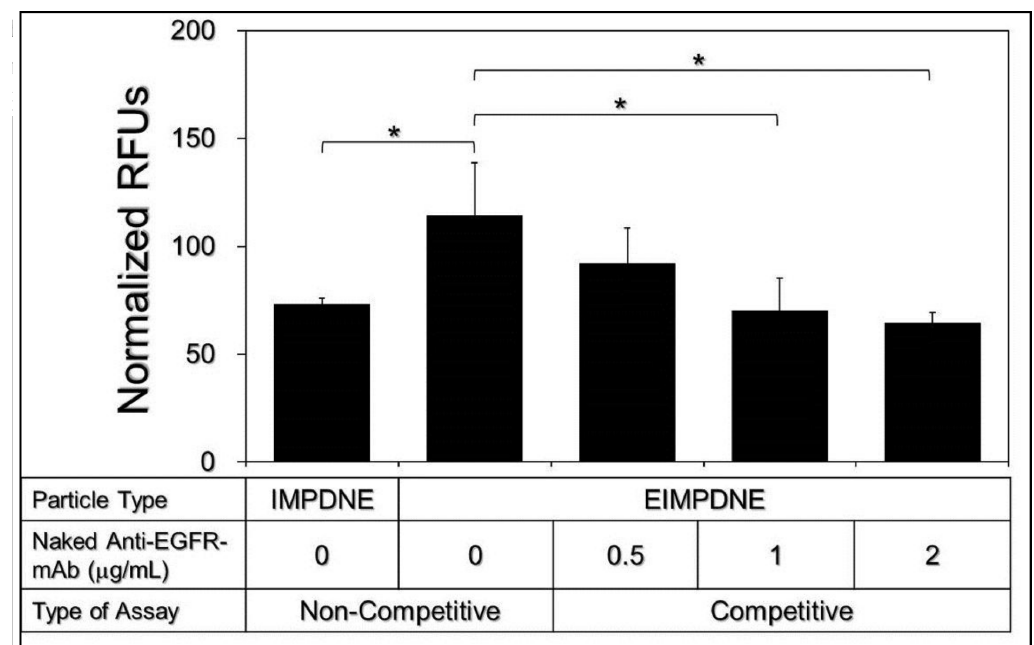
Figure 5. Identification of the EGFR-binding specificity of the EIMPDNEs in vitro using EGFR-expressing T24 cells. In the non-competitive assay, the cells were treated with IMPDNEs or EIMPDNEs in the absence of anti-EGFR-mAb for 4 h. Both types of nanodroplets were used in a 20 µ M ICG/18 µ M MMC equivalent concentration to the cells. For the competitive assay, the cells were first co-incubated with 0.5, 1, or 2 µ g mL − 1 of naked anti-EGFR-mAb at 37 ◦ C for 4 h, followed by incubation with EIMPDNEs for another 4 h. The ICG-derived fluorescence in each group was detected using spectrofluorometry performed with a 750 nm excitation wavelength and 838 nm emission wavelength immediately after the nanodroplets were removed, and they were quantitatively analyzed by RFUs after normalization against the group without nanodroplets. Values are mean ± s.d. ( n = 3), * p <